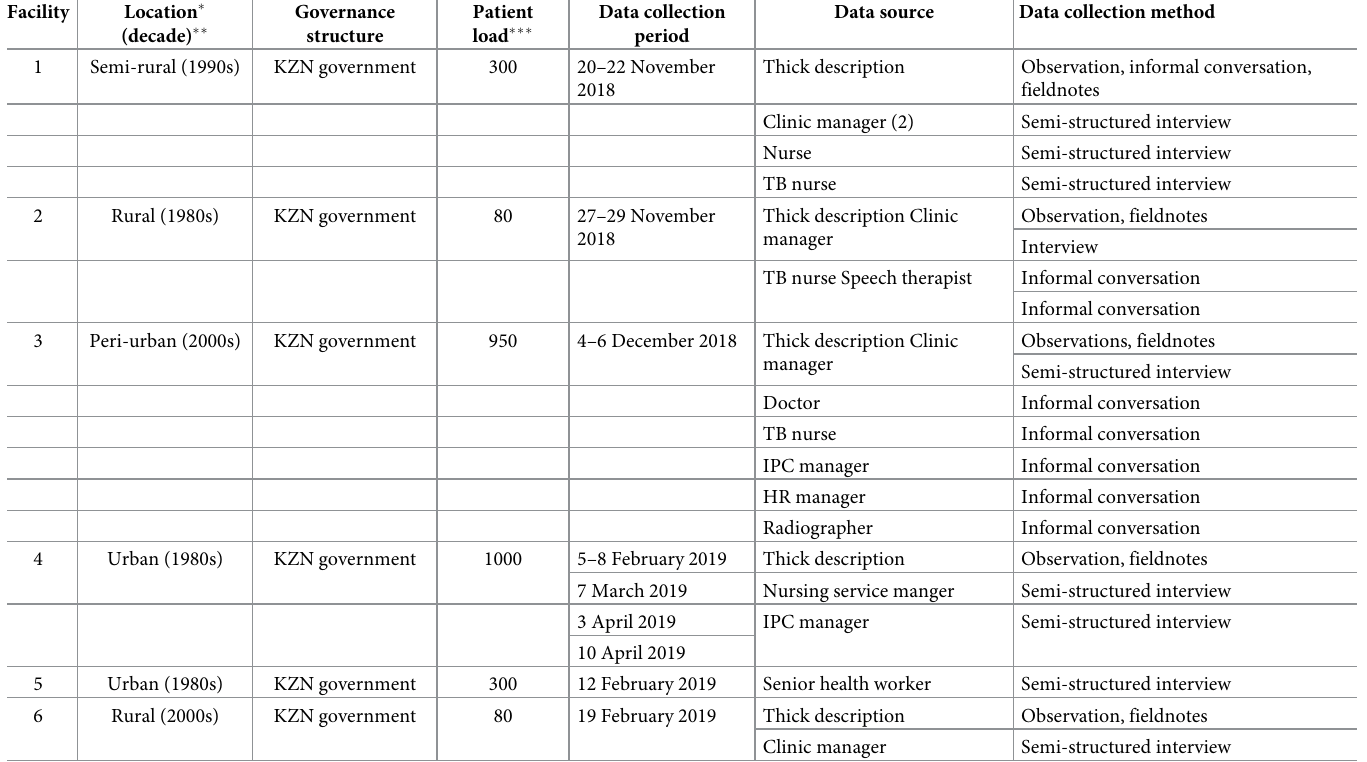
Table 2. Description of clinics and data collection